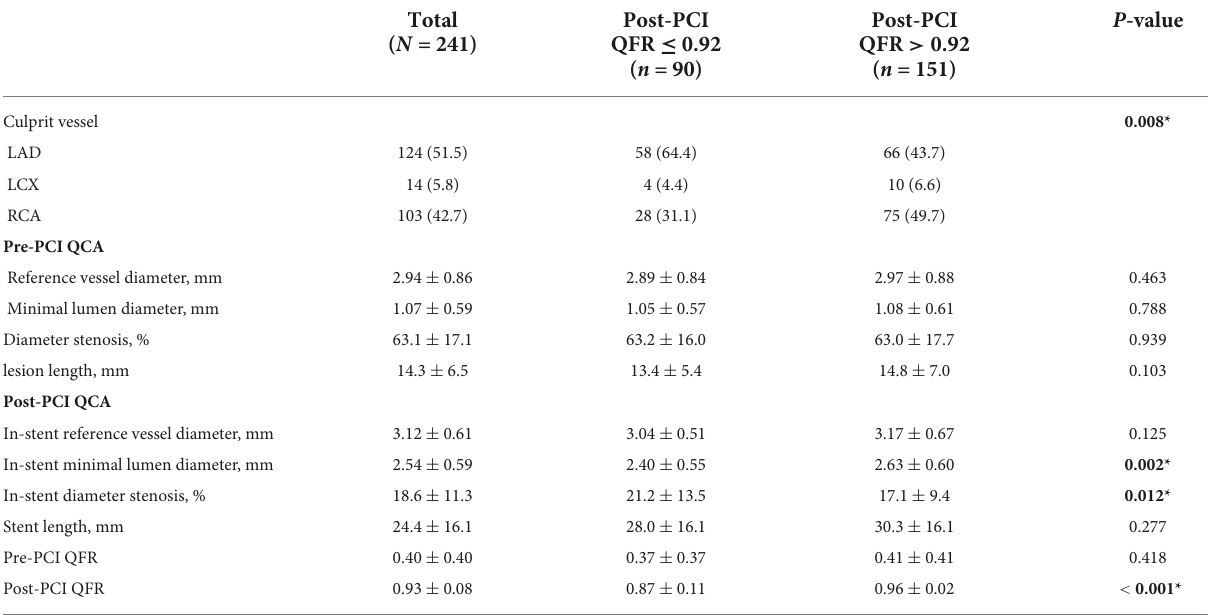
TABLE 2 Coronary characteristics.